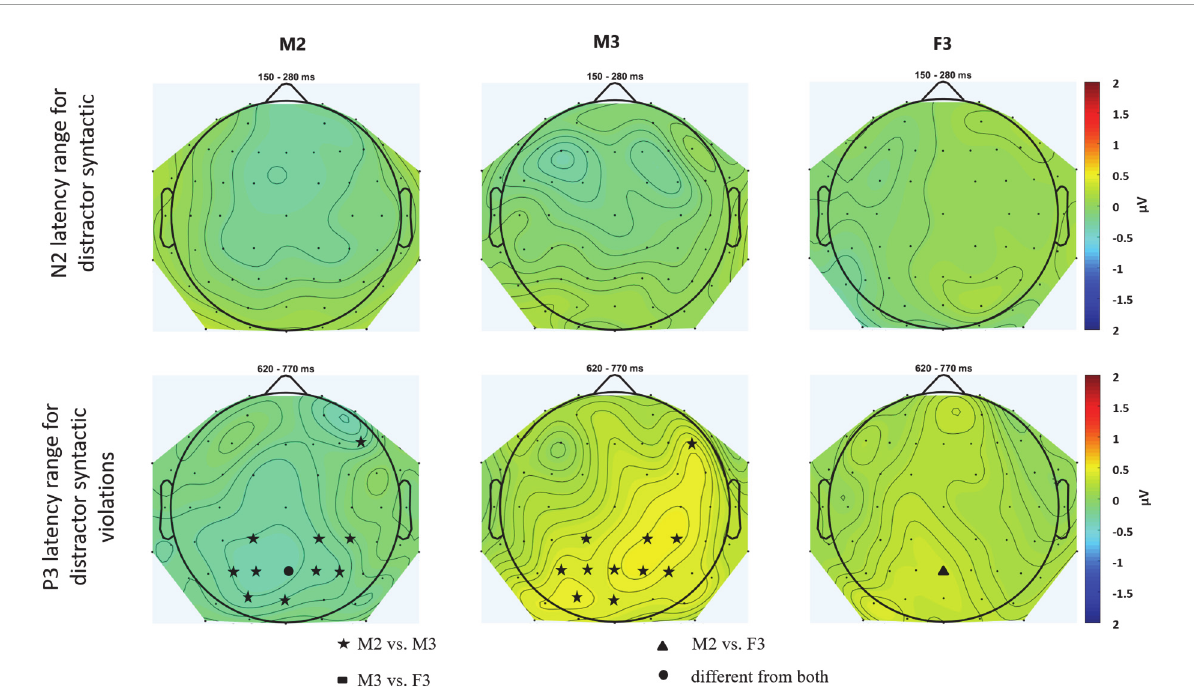
FIGURE5 Scalp topography of the N2 (upper row) and P3 (bottom row) latency range for distractor syntactic violations for the three distractor streams: M2 – male speaker in the one-distractor condition, M3 – male speaker in the one-distractor condition, F3 – female speaker in the two-distractor condition. The scalp distributions were calculated from the average voltages measured from the time windows shown in Figure 2 . Maps were spline interpolated with a smoothing factor of 10 − 7 . Electrode locations marked by filled circles, stars, triangles, and rectangles represent the scalp locations where the signal in the given latency range significantly differed from one (filled stars, rectangles, or triangles) or both (circles) other conditions. Tests were computed by pair-wise post hoc comparisons of the corresponding ANOVA with the factors of CONDITION and ELECTRODE LOCATION (including all electrodes; thus replacing the factors ANTERIOR-POSTERIOR and